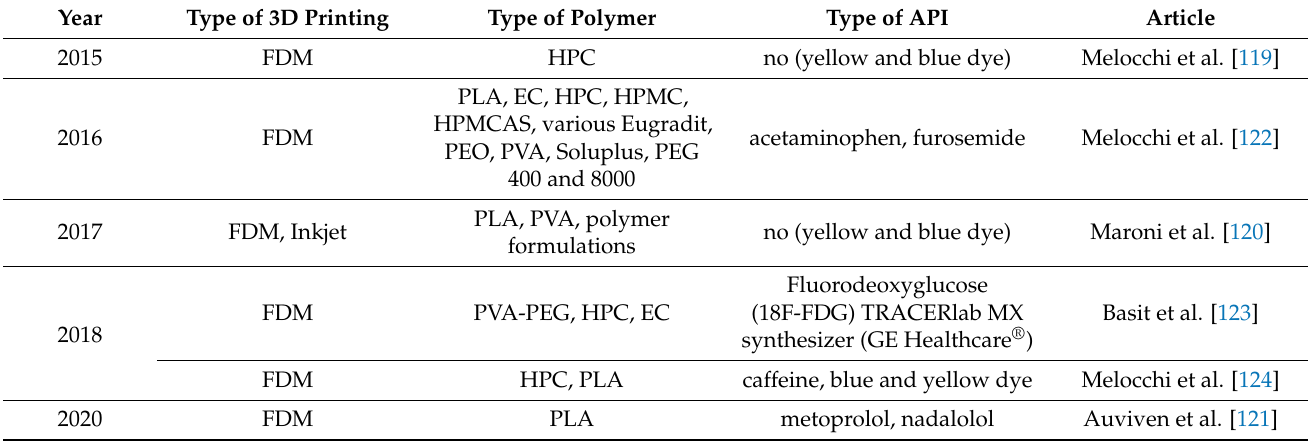
Table 3. The grouping of the manufactured capsules based on the publication year and then in alphabetical